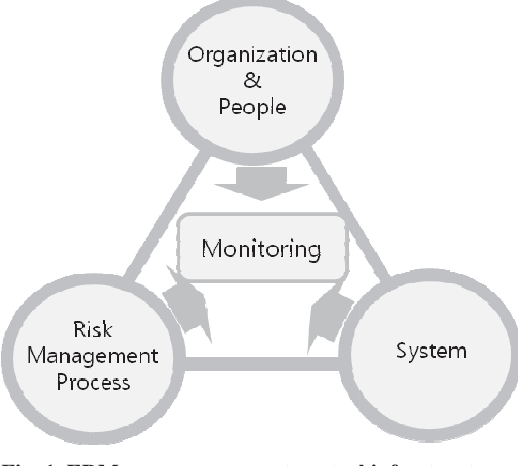
l infrastructur nd ERM. Tr has a compli gic approach nt’s needs. udit system i orting, to com SEC regulat , CFO and a l focus on fi f control pro On the cont